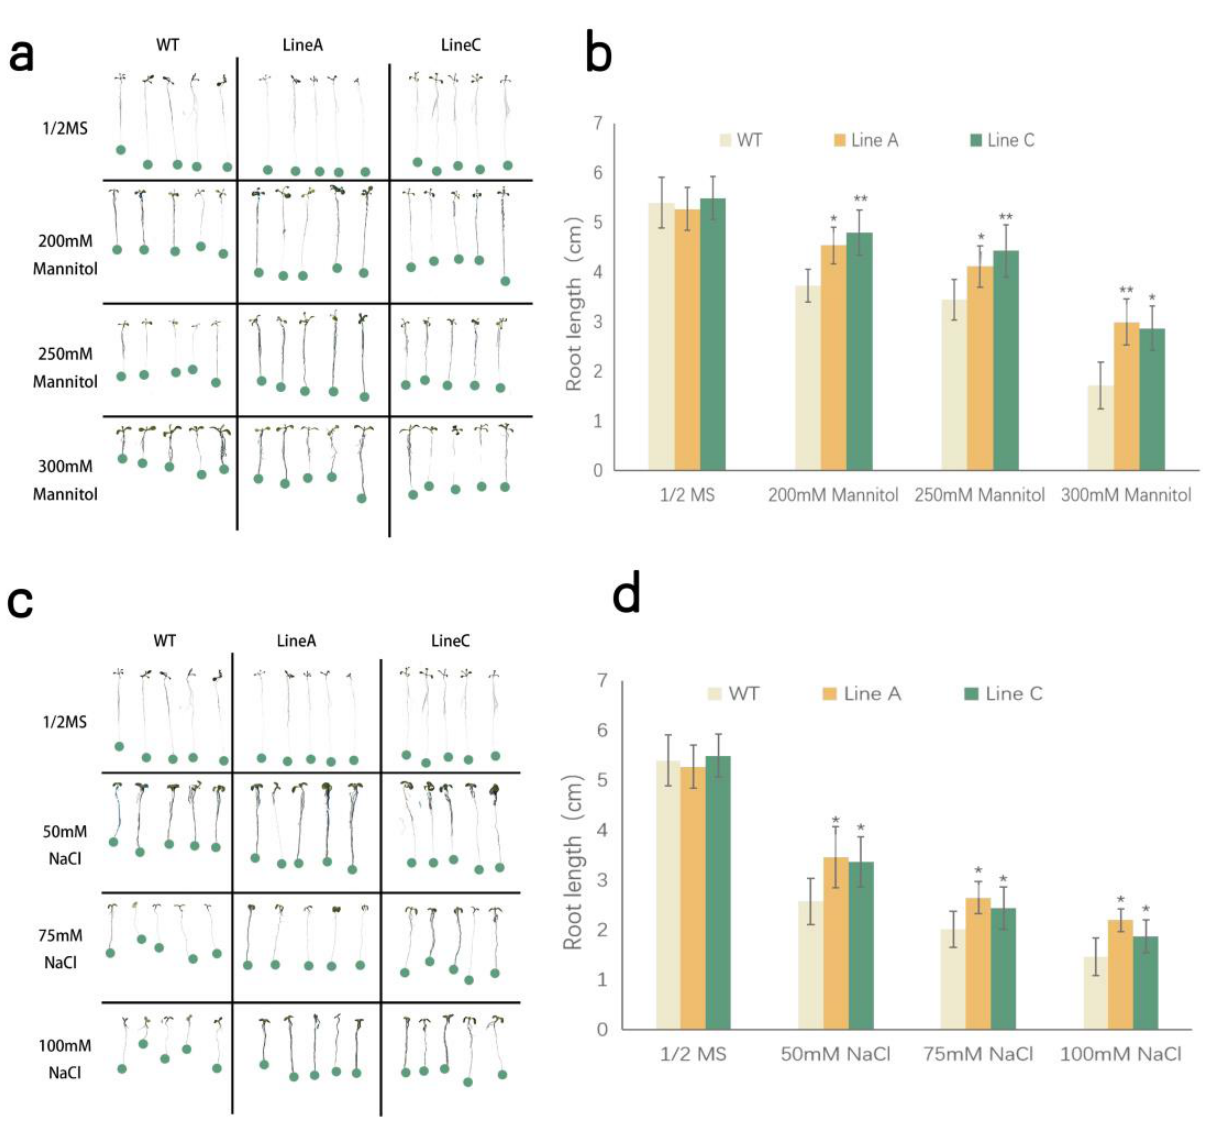
A were still green (Figure 4b). The above results showed that Arabidopsis overexpressing MfWRKY40 exhibited better tolerance to drought and salt stresses.